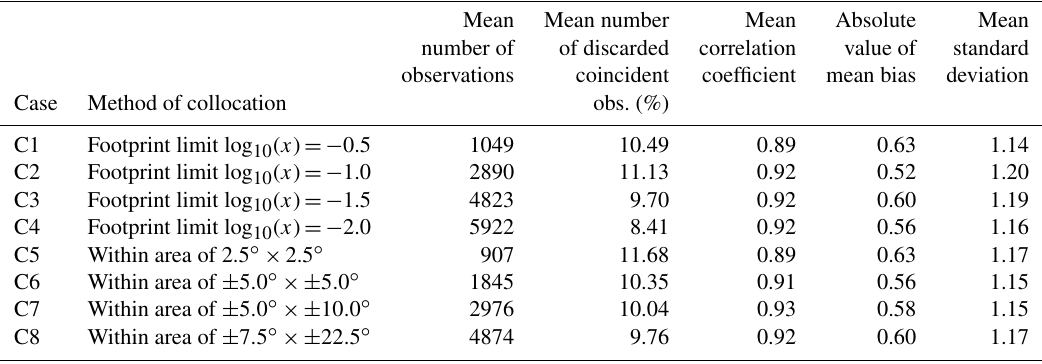
Table 5. Averaged results of different collocation methods implemented for XCO 2 from the GOSAT NIES product calculated for 16 TCCON sites.